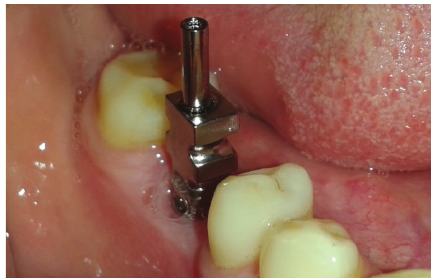
Figure 17: Coping screw removed.